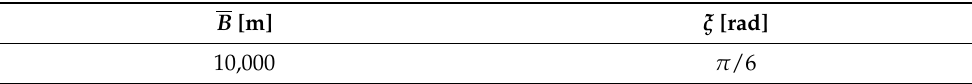
Table 5. Initial value for the beam